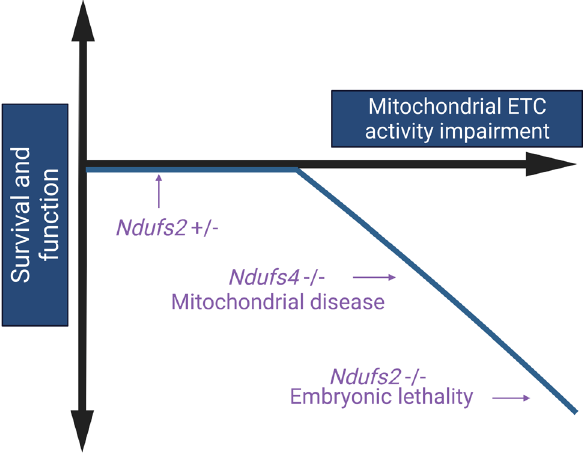
Figure 5. Proposed qualitative model of the relationship between mitochondrial electron transport chain impairment and survival and function in vertebrates. Created with https:// biore nder.